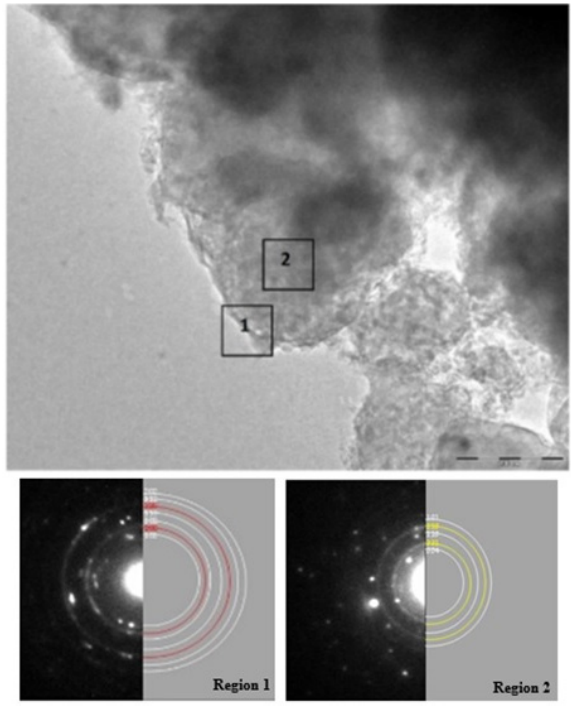
Figure 6. Transmission electron microscopy (TEM) micrograph of MgH 2 + 5 mol% MgF 2 sample after desorption at 335 °C with selected area electron diffraction (SAED) patterns and simulations. Region 1 is composed of Mg ( white rings ) covered with MgO layer ( red rings ) in simulated data while Region 2 shows diffraction rings corresponding to Mg ( white rings ) and MgF 2 ( yellow rings ).